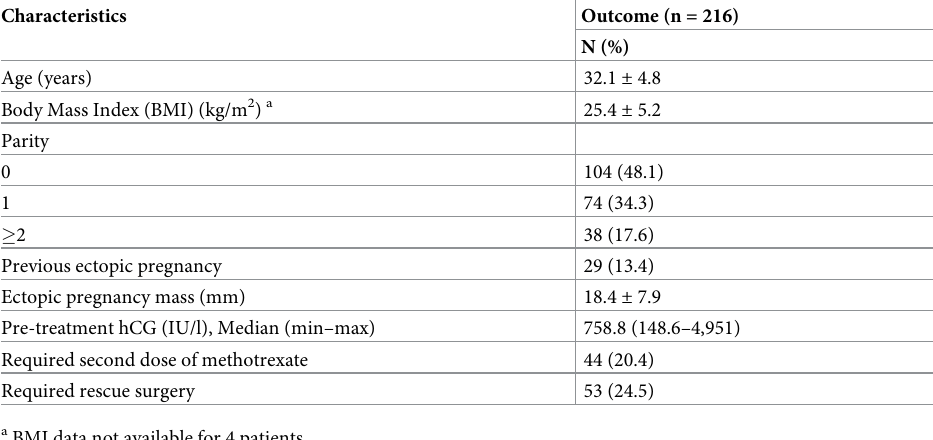
Table 1. Patient baseline demographics and ectopic pregnancy characteristics.